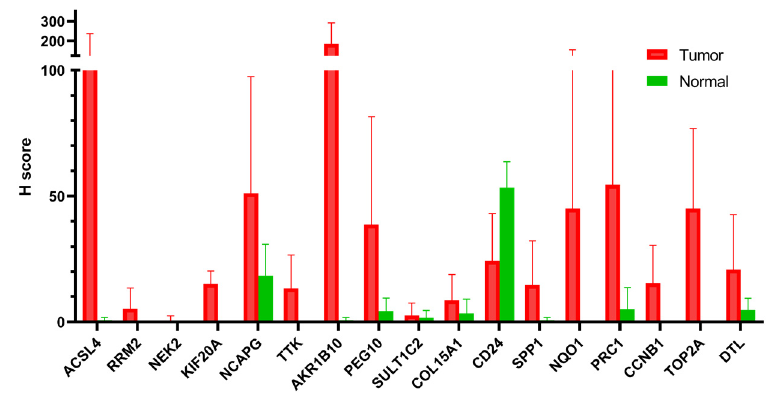
Figure 5. Immunohistochemistry ‐ based evaluation of proteins coded by 17 PCM1 genes. Mean H scores are shown in the y ‐ axis. Error bars indicate standard deviations.